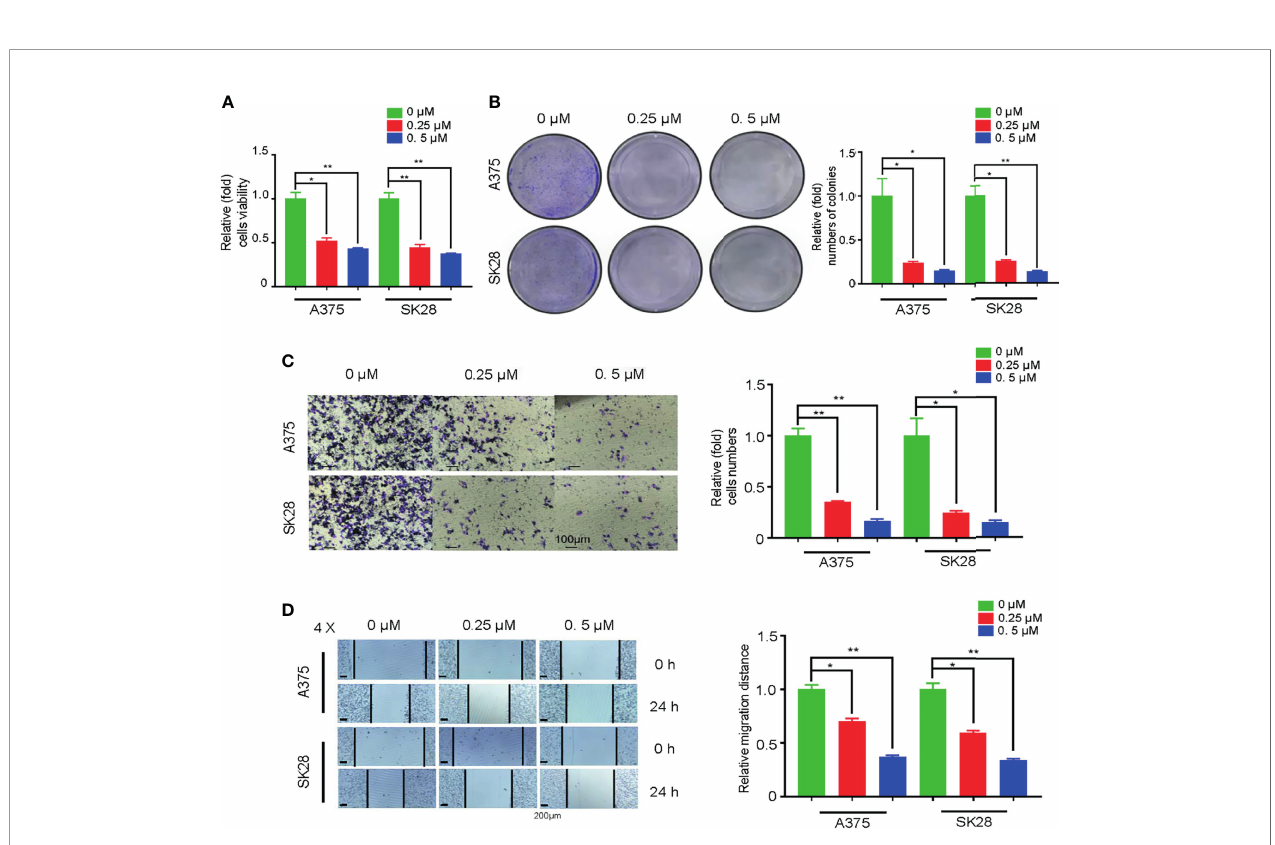
FIGURE 7 | Oxidative phosphorylation (OxPhos) inhibitor attenuated proliferation and migration of skin cutaneous melanoma (SKCM) cells. (A) The growth ability of SKCM was attenuated after treatment with OxPhos inhibitor by Cell Counting Kit-8 (CCK-8) assay. (B) Colony formation assay demonstrated that SKCM formed smaller and fewer colonies after treating with 0.25 and 0.5 m M rotenone. (C, D) Cellular migration capacity was signi fi cantly attenuated by Transwell and wound healing assay after treatment with OxPhos inhibitor. *p < 0.05, **p < 0.01